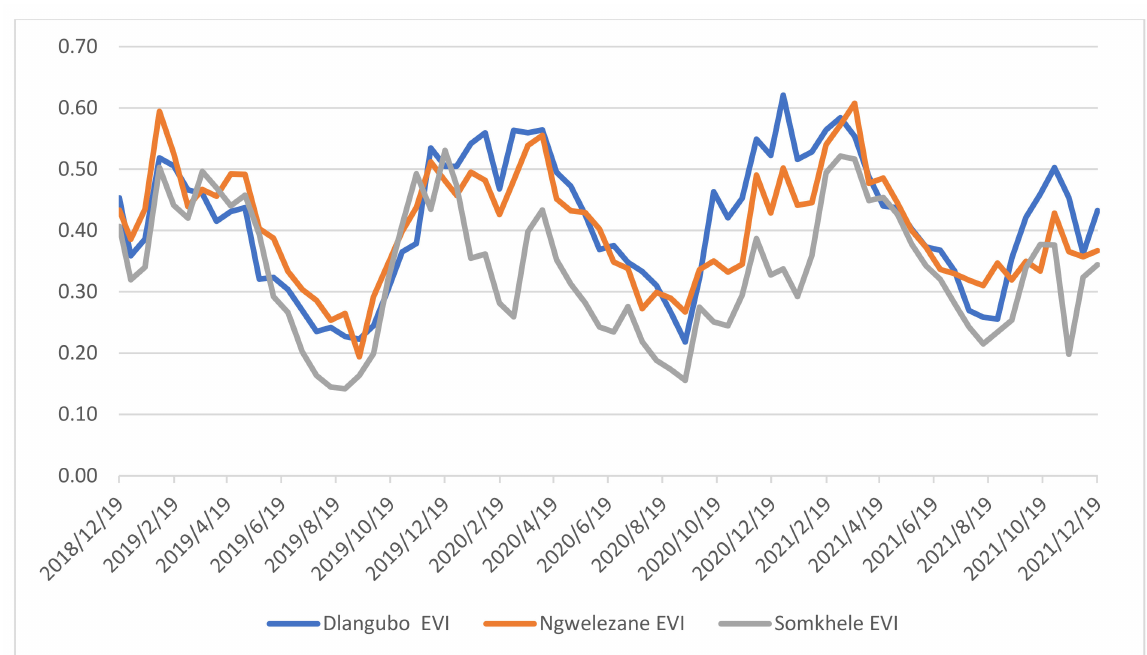
Figure 3. Time series of the Enhanced Vegetation Index in the Dlangubo, Ngwelezane, and Somkhele (Mtubatuba) sites from 19 December 2018 to 19 December 2021. As EVI declined, the greenness and water status of the vegetation declined. Values below 0.2 show very poor vegetation [35] and it only occurred at the Somkhele site and in the second season.